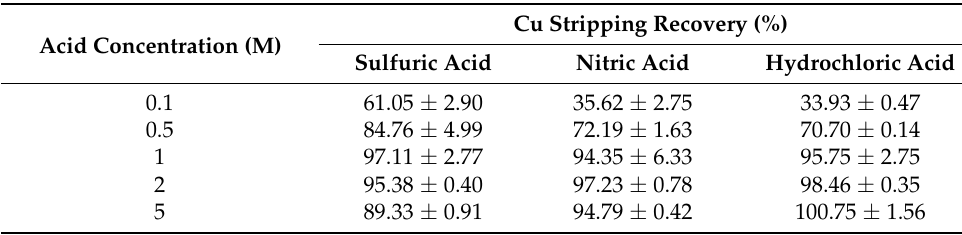
Table 4. Cu stripping recovery according to mineral acid type and acid concentration (O/A 1, feed organic LIX ® 84-I 10% v / v , Cu 4.8 g/L).